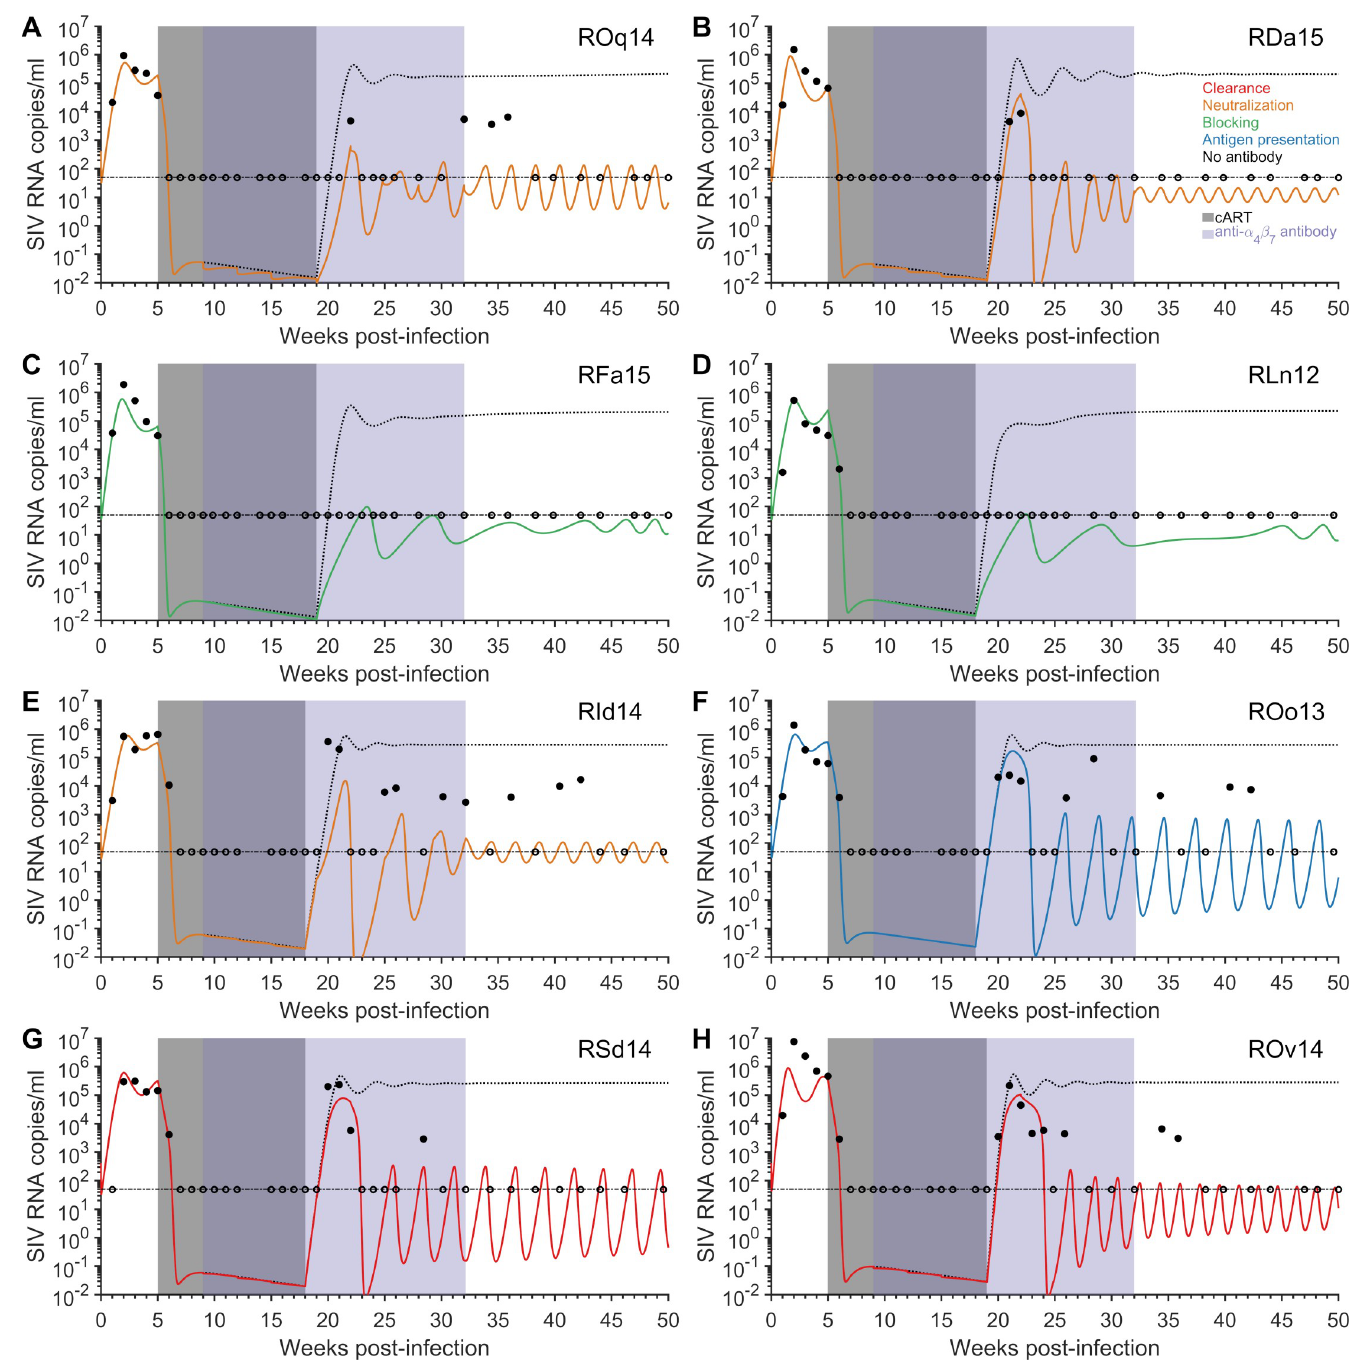
Fig 2. Fit of the model to the data. The measured ( � 50 SIV RNA copies/ml solid circles and < 50 SIV RNA copies/ml open circles) and model predicted viral loads (solid line) using the best-fit parameter estimates and model variation with the greatest AIC weight for each of the treated macaques and predicted viral dynamics in the absence of the anti- α 4 β 7antibody (dotted black line), panels A)–H). The limit of detection is 50 SIV RNA copies/ml (thin horizontal dashed black line). Treatment with cART occurred between five weeks and 18/19 weeks post-infection (gray area), while eight infusions of the anti- α 4 β 7antibody occurred between nine weeks post- infection and 32 weeks post-infection (purple area). The mechanisms considered include increased viral clearance (red line), virus neutralization (orange line), target cell protection (green line), and increased antigen presentation (blue line). Parameters for these simulations are in Tables 1 and S14–S18, for the AIC selected model (Table